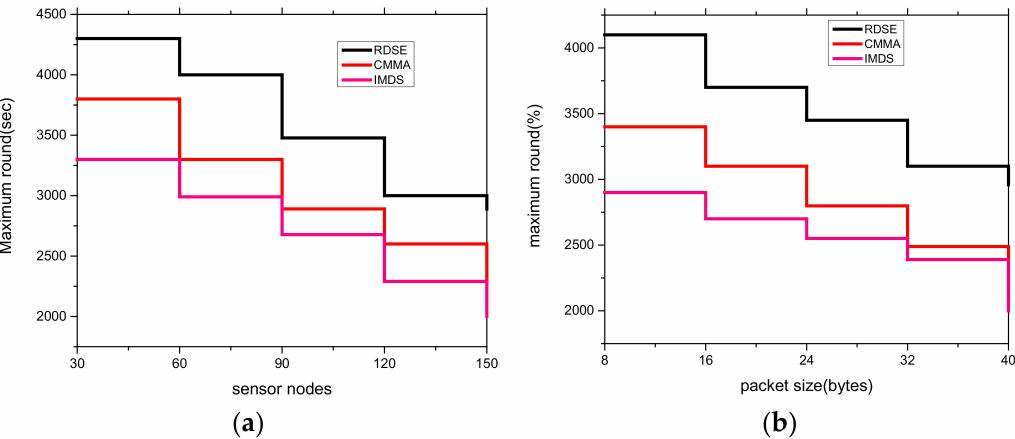
Figure 6. The number of rounds with ( a ) varying sensors “30–150”, and ( b ) varying packet sizes “8–40